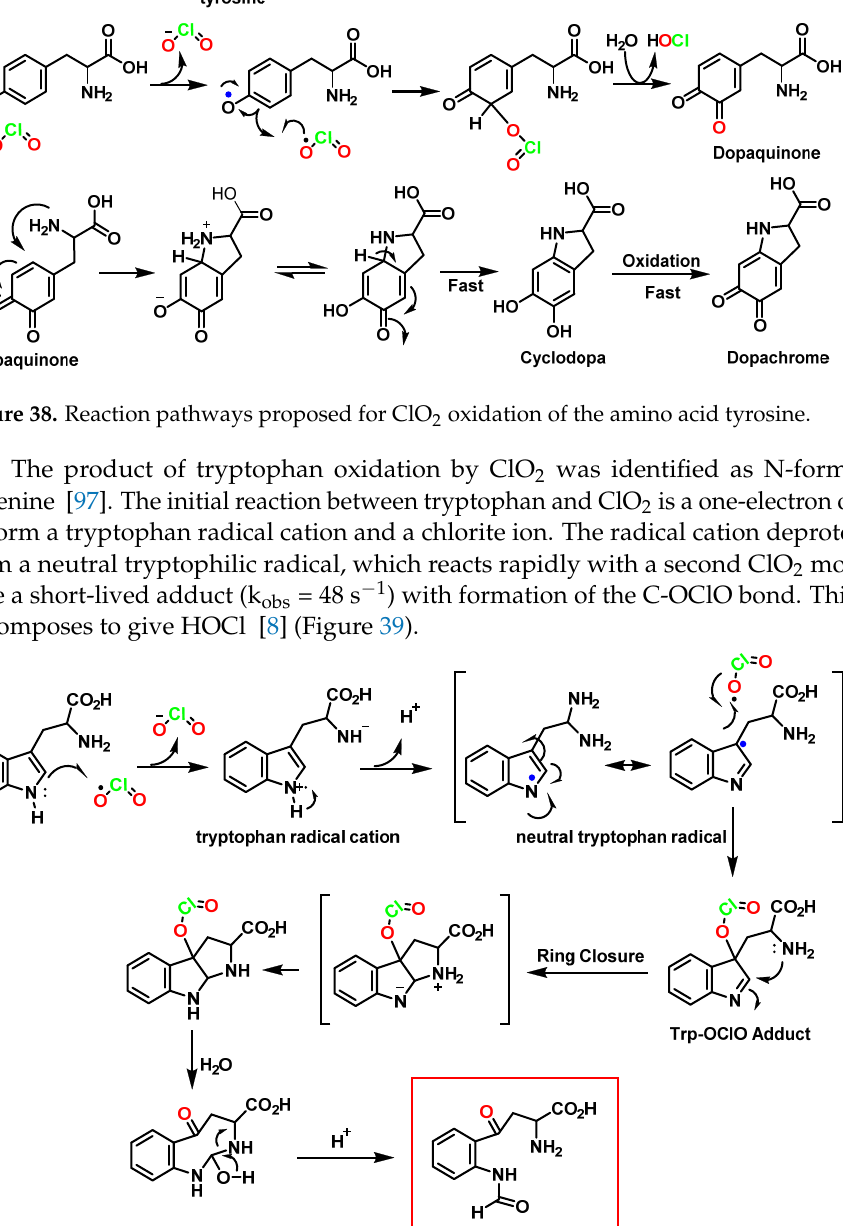
Figure 40. Stoichiometry of the reaction between tryptophan and ClO 2 . 5.6. Oxidation of Peptides and Proteins by ClO 2 ClO 2 is a selective oxidant that only reacts with five amino acids: cysteine, tyrosine, tryptophan, histidine, and proline. Cysteine, tyrosine, and tryptophan have much faster reaction rate constants. Mass spectrometry and nuclear magnetic resonance spectroscopy show that tryptophan residues are converted to N ‐ formyl alkyl ‐ nurenine and tyrosine residues are converted to 3,4 ‐ dihydroxyphenylalanine (DOPA) or 2,4,5 ‐ trihydroxy ‐ phenylalanine (TOPA) in ClO 2 ‐ treated proteins. Tryptophan residues are critical targets in the reaction between ClO 2 and proteins[98,99], causing protein fragmentation and de ‐ naturation. Inactivation of influenza A virus when treated with ClO 2 has been observed due to oxidation of a tryptophan residue (W 153 ) that was converted to NFK in hemagglu ‐ tinin, restricting its ability to bind to host cells[100]. Using bovine serum albumin and glucose ‐ 6 ‐ phosphate dehydrogenase (G6PD) from baker’s yeast ( Saccharomyces cerevisiae ) as model proteins, it was shown that the antimicro ‐ bial activity of ClO 2 is mainly attributed to its protein denaturing activity. Elemental anal ‐ yses show that oxygen atoms, but not chlorine atoms, are incorporated into the ClO 2 ‐ treated protein, providing direct evidence that ClO 2 oxidizes the protein. For glutathione, a tripeptide consisting of glycine, cysteine, and glutamic acid, the ClO 2 ‐ reactive site is the thiol group, and the oxidation products are like those of cysteine (Table 3).